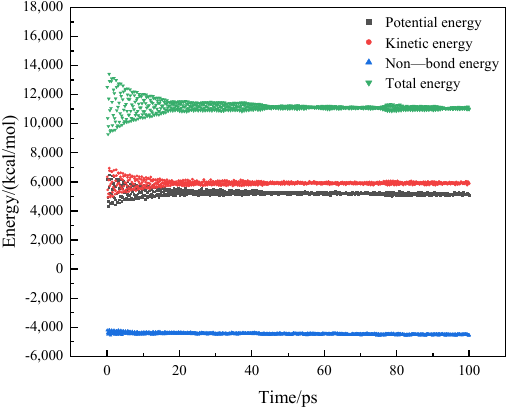
Figure 3. The energy of the asphalt model during the simulation.